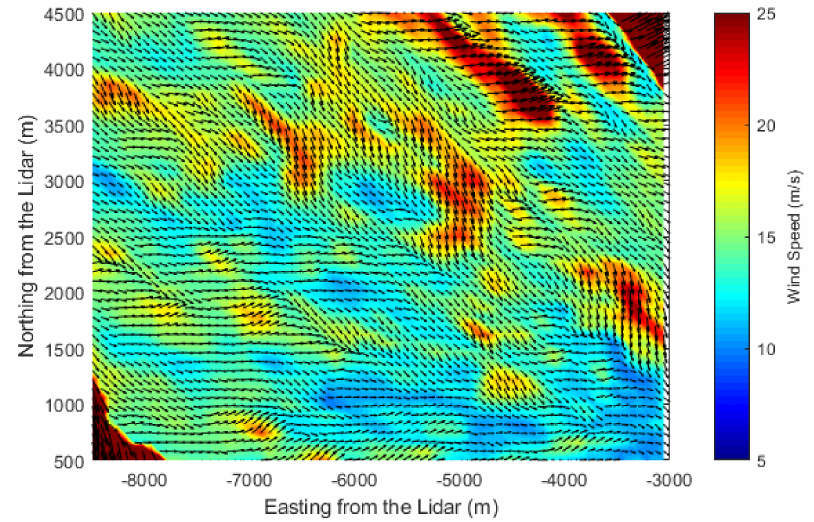
Figure 1. Wind field retrieved by the two-dimensional variational analysis method (2D-VAR) algorithm. Background colors indicate the magnitude of the local wind speed, and the arrows show the local wind